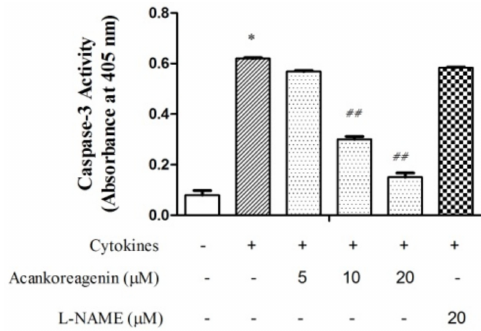
Figure 6. Effects of acankoreagenin on the cytokine-induced caspase-3 activity in the RIN-m5F cells. The RIN-m5F cells were pretreated with the indicated concentrations of samples for 1 h and then IL-1 β (10 ng/mL) and IFN- γ (100 ng/mL) were added. Caspase-3 activity was based on spectrophotometric detection of the chromophore p-NA after cleavage from the labeled substrate DEVD-pNA. * p < 0.05 versus vehicle-treated control; ## p < 0.01 versus cytokine-treated group. Bars indicate SEM ( n = 3).